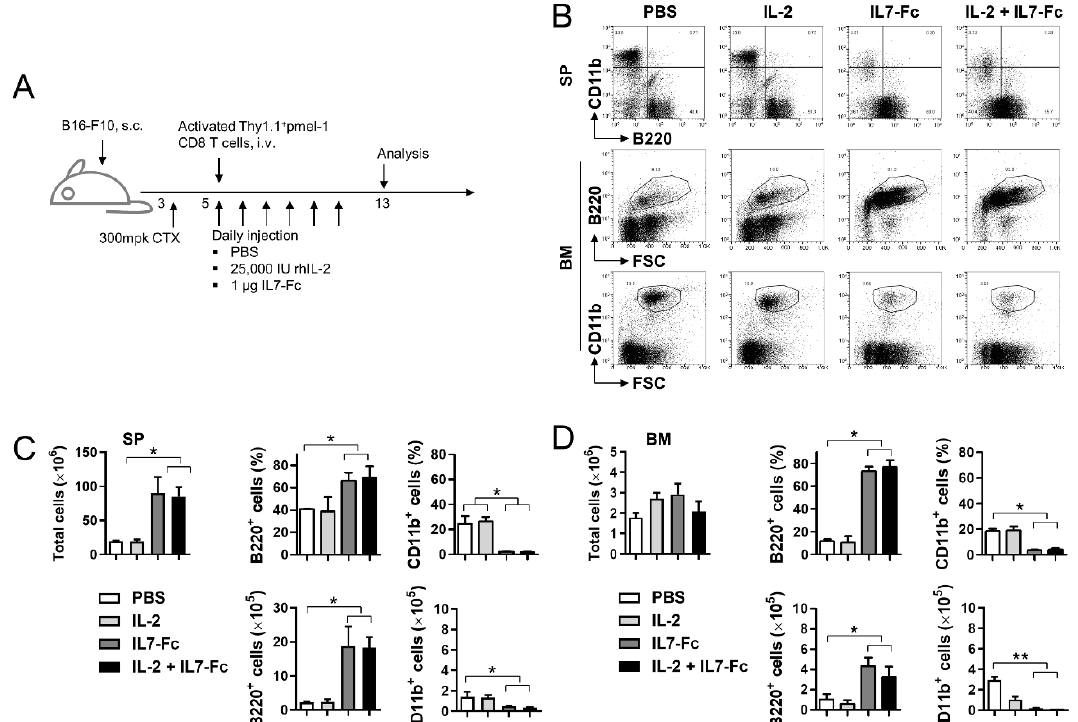
Figure 3. Effects of IL7-Fc on myeloid and lymphoid cells in bone marrow and spleen. ( A ) B16-F10 melanoma-bearing C57BL/6 mice were sequentially injected with CTX, activated pmel-1 Thy1.1 + CD8 + T cells, and further treated with PBS, rhIL-2, hIL7-Fc, or rhIL-2 plus hIL7-Fc as described above. ( B ) BMs and spleens were collected from mice on day 13 and single cell suspensions were stained with anti-CD11b-PE-Cy5 and anti-B220-FITC. All samples were further stained with propidium iodide (PI) and subsequently analyzed using FACSCalbur (BD Bioscience). Live cells were gated and plotted as the indicated markers. ( C ) Absolute numbers of spleen cells were counted, and the percentages and absolute numbers of CD11b + monocytes and B220 + B cells were calculated. ( D ) Absolute numbers of BM cells were counted, and the percentages and absolute numbers of CD11b + monocytes and B220 + B cells were calculated. Data are from two independent experiments with 3 mice per experiment. Student’s t -test was performed in ( C , D ), and the results are expressed as mean ± SD (* p < 0.05; ** p < 0.01).